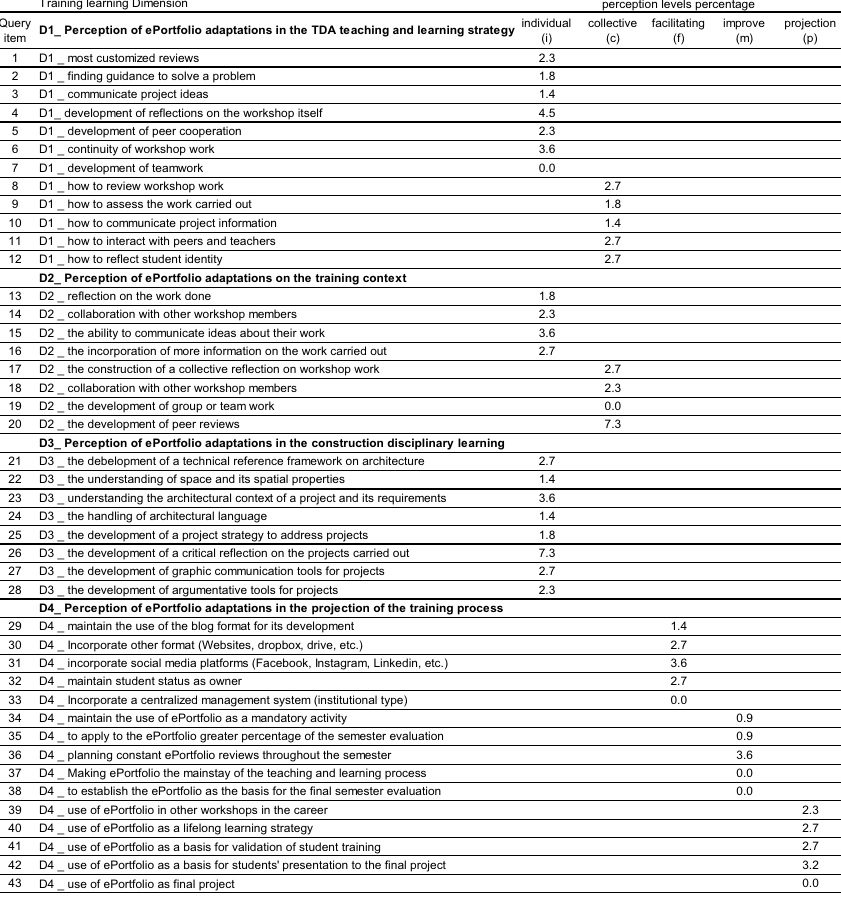
Table 3 Perception level about the ePortfolio actions contributing to NLP development Training learning Dimension Query